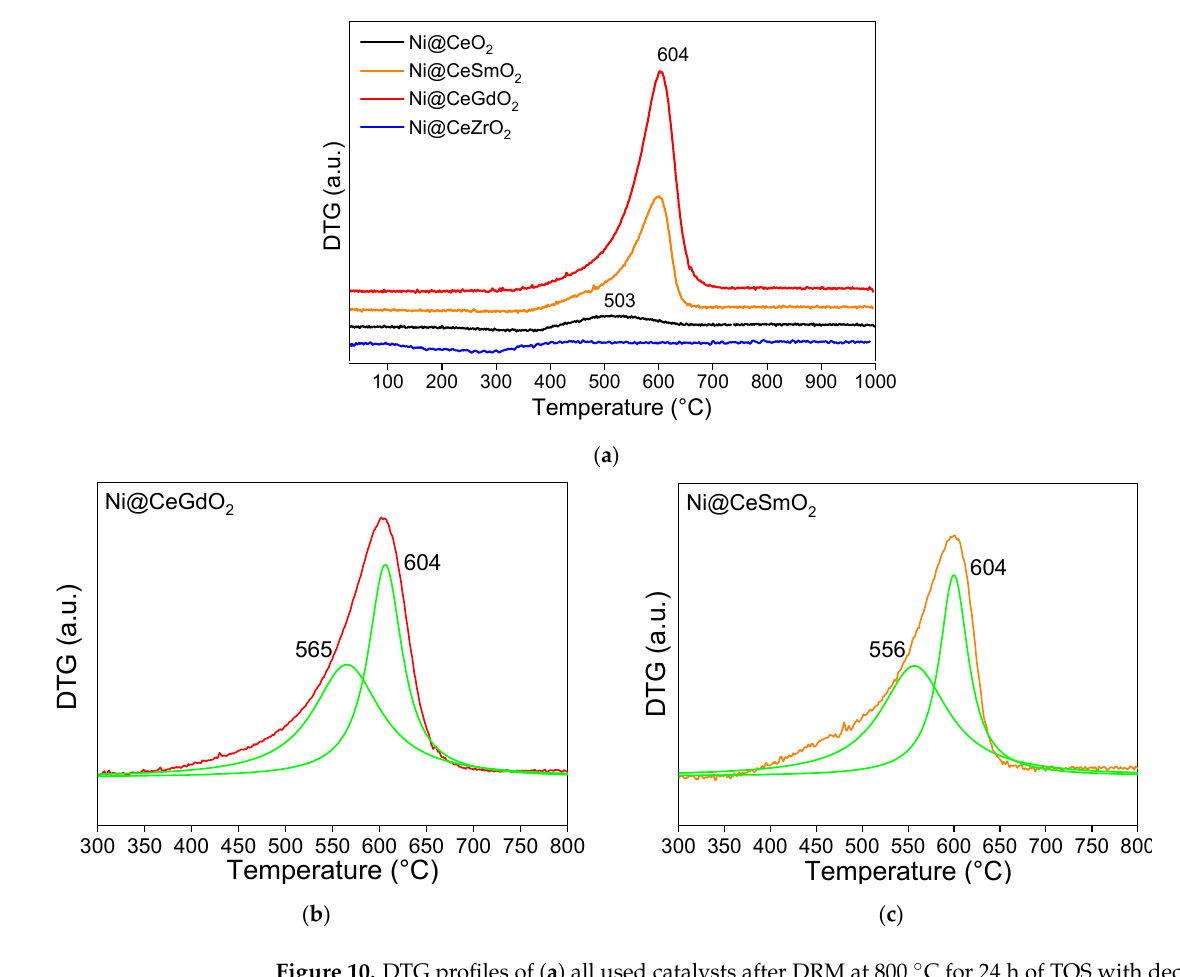
Figure 10. DTG profiles of ( a ) all used catalysts after DRM at 800 °C for 24 h of TOS with decomposition of the profiles for ( b ) Ni@CeGdO 2 and ( c ) Ni@CeSmO 2 .